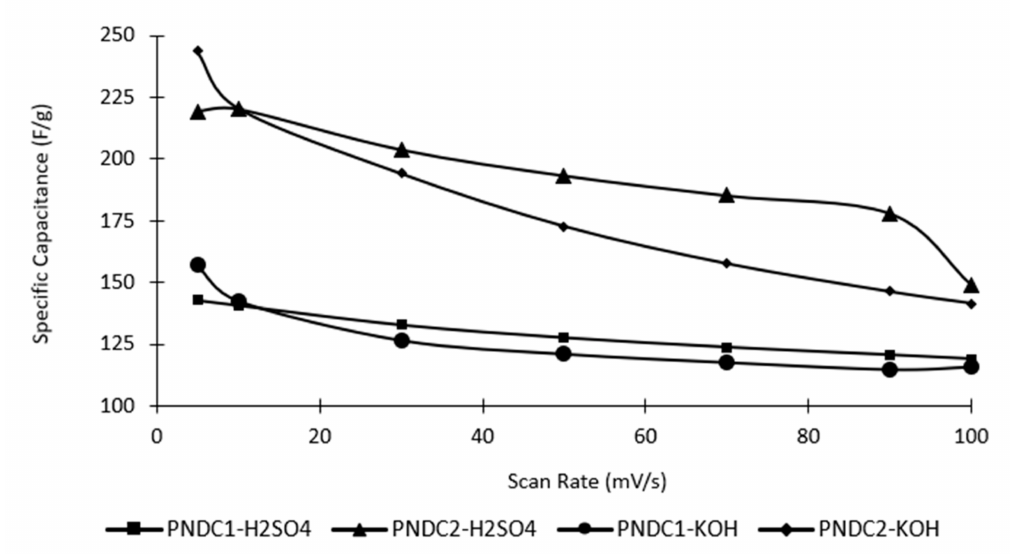
Figure 5. Plot demonstrating dependence of specific capacitance on scan rate vs. 1 M sulfuric acid (H 2 SO 4 ) and 6 M